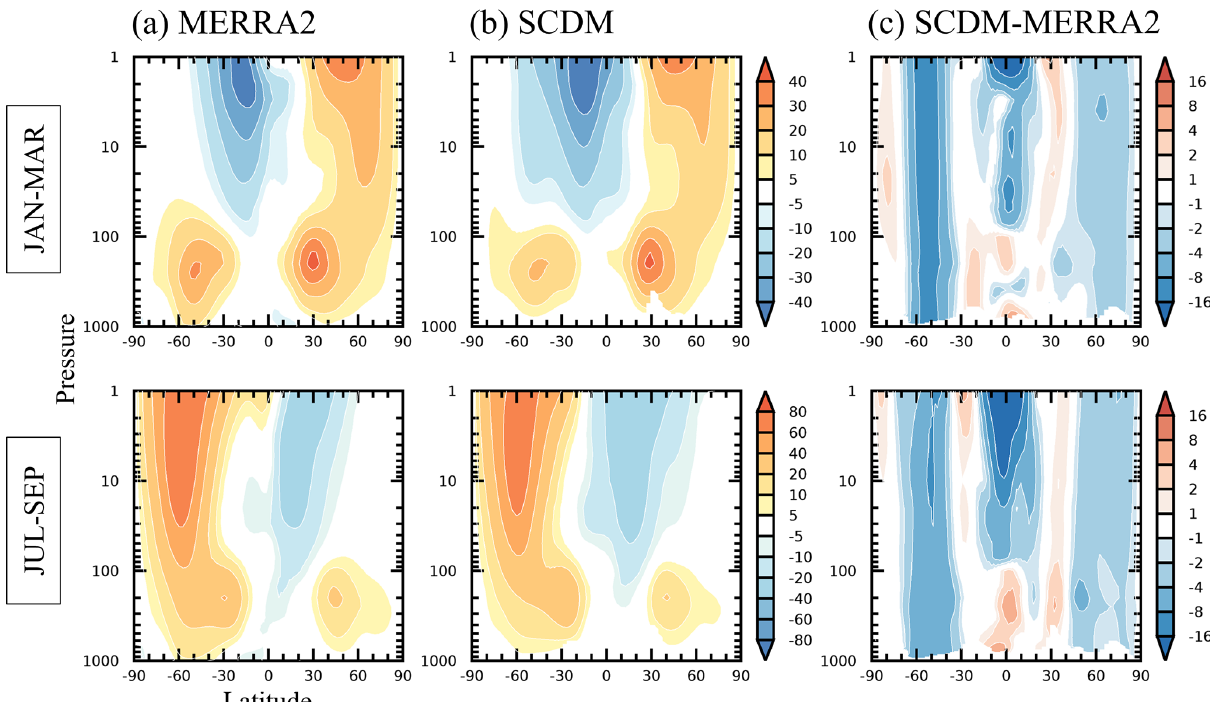
Figure 5. Latitude–height cross-sections of zonal-mean zonal wind (ms − 1 ) for (a) MERRA2, (b) SCDM, and (c) SCDM minus MERRA2. Shown are seasonal climatologies for boreal winter (January–March) and austral winter (July–September). Shading in (c) passes statistical significance at the 95% level.